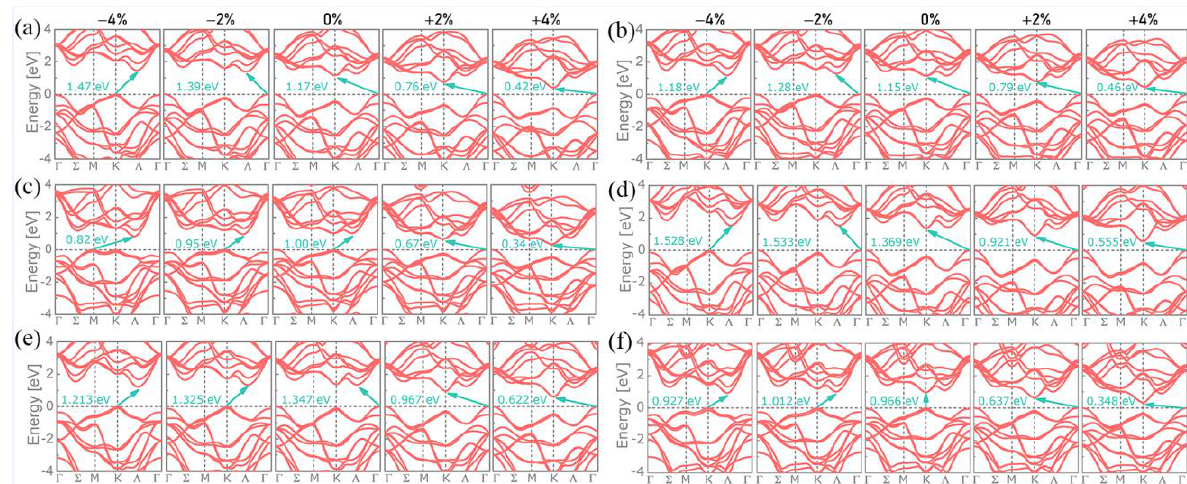
Figure 2. Band structures of ( a ) MoS 2 , ( b ) MoSe 2 , ( c ) MoTe 2 , ( d ) WS 2 , ( e ) WSe 2 , and ( f ) WTe 2 . For each panel, from left to right: −4%, −2%, 0%, +2%, and +4% applied biaxial strain.